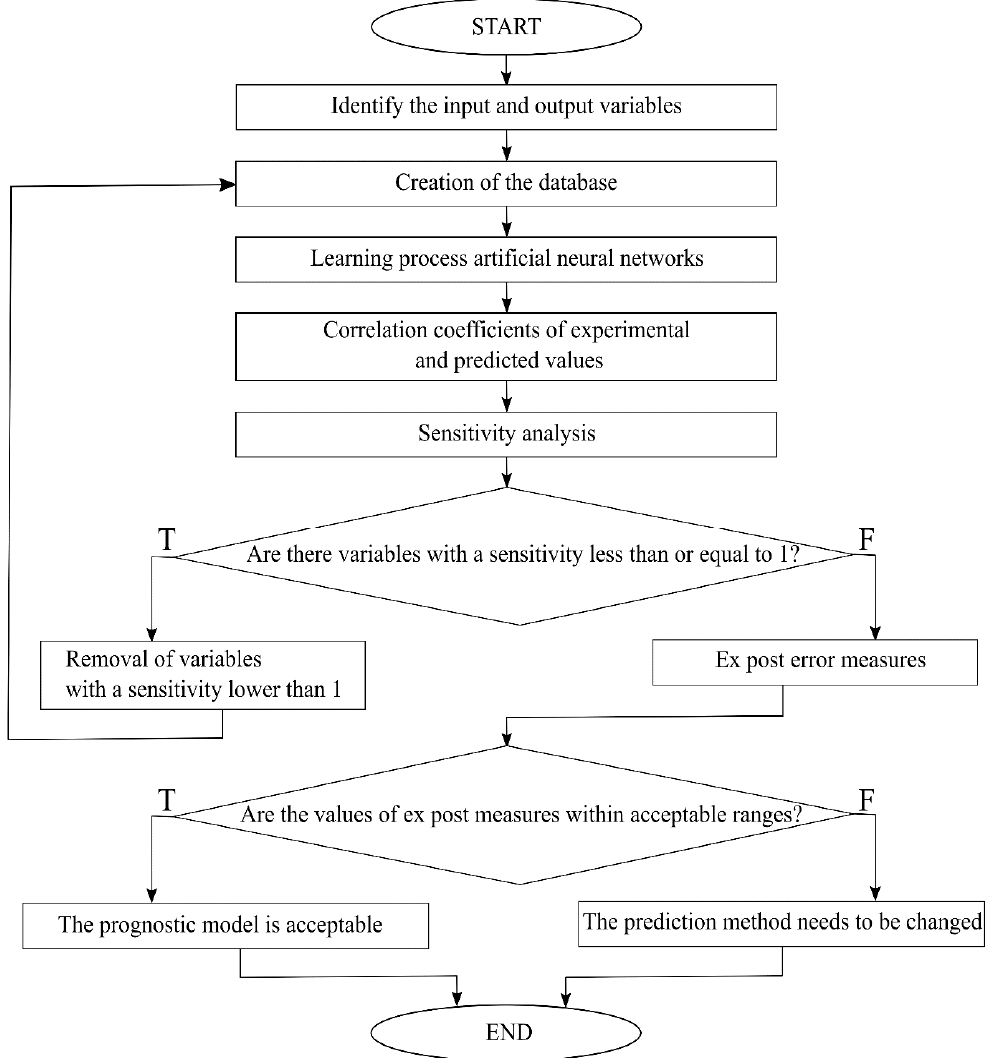
Figure 1. The concept of creating a prognostic model using ANNs.